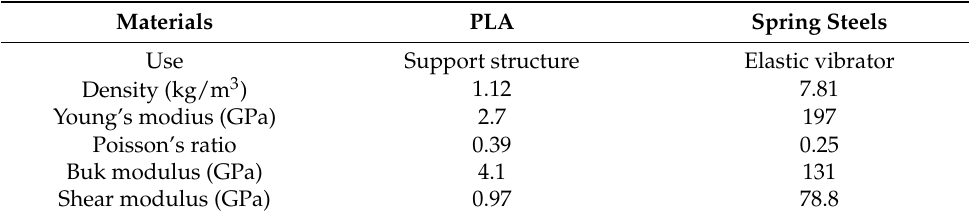
Table 1. Basic parameters of materials.